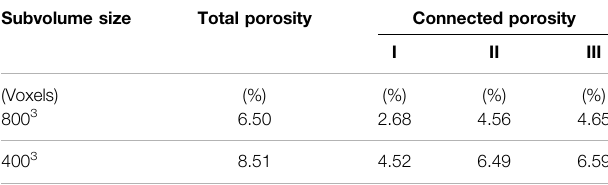
TABLE4| Derivedporositymeasurementsconsideringthreecasesofsegmented pore voxels obtained for the 800 3 and 400 3 voxel subvolume, respectively. Subvolume size